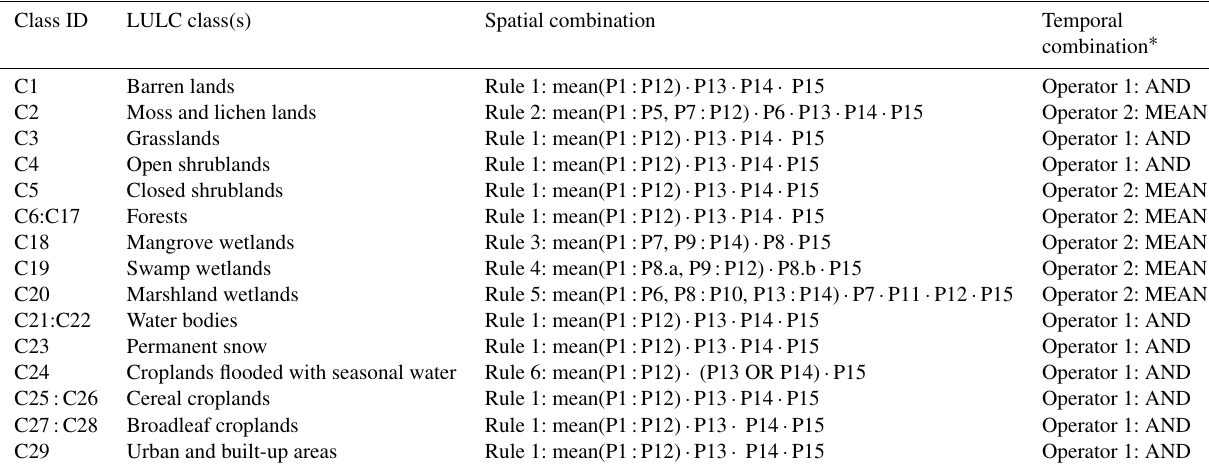
Table 5. Description of the temporal–spatial combination of the 15 global LULC products (P1 : P15) masks to build a consensus image for each LULC class.